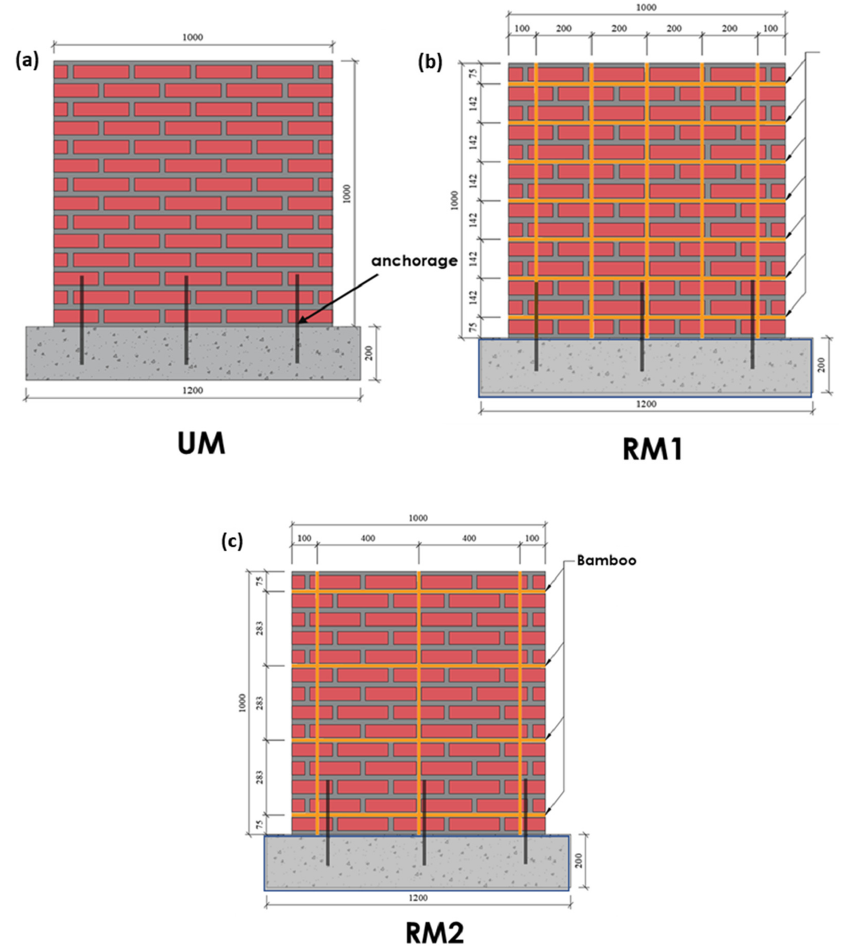
Figure 11. Sketches of three masonry panel models: ( a ) without retrofitting, ( b ) with 2.88% of bamboo retrofitting, ( c ) with 1.44% of bamboo retrofitting. To consider only the effect of bamboo reinforcement in this experimental study, no finishing mortar layer was applied to the masonry panels. On the other hand, in real ap- plications, the finishing mortar layer may increase the shear strength of the panels.